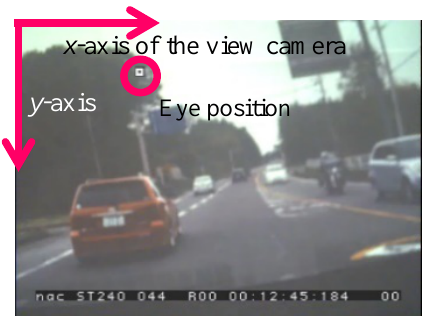
Figure 3: Output image of the view